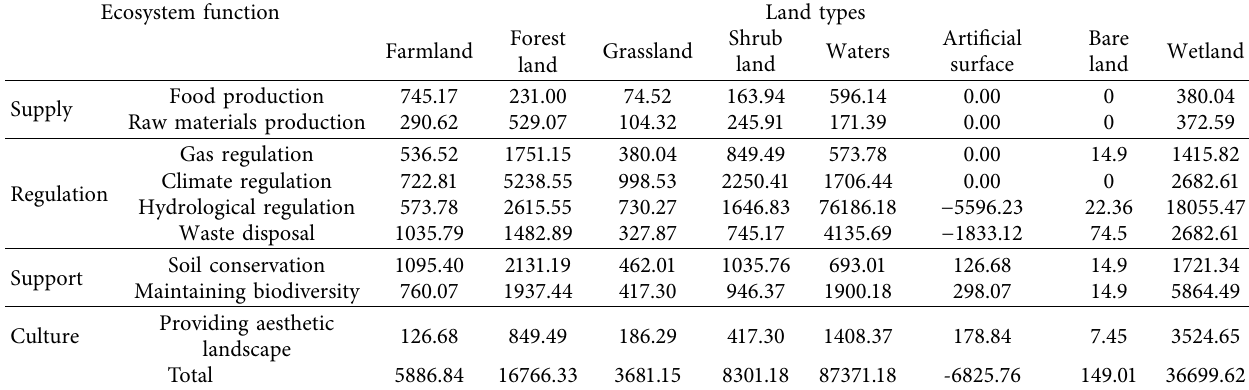
Table 1: Ecological service value per unit area of Land (Yuan/hm 2